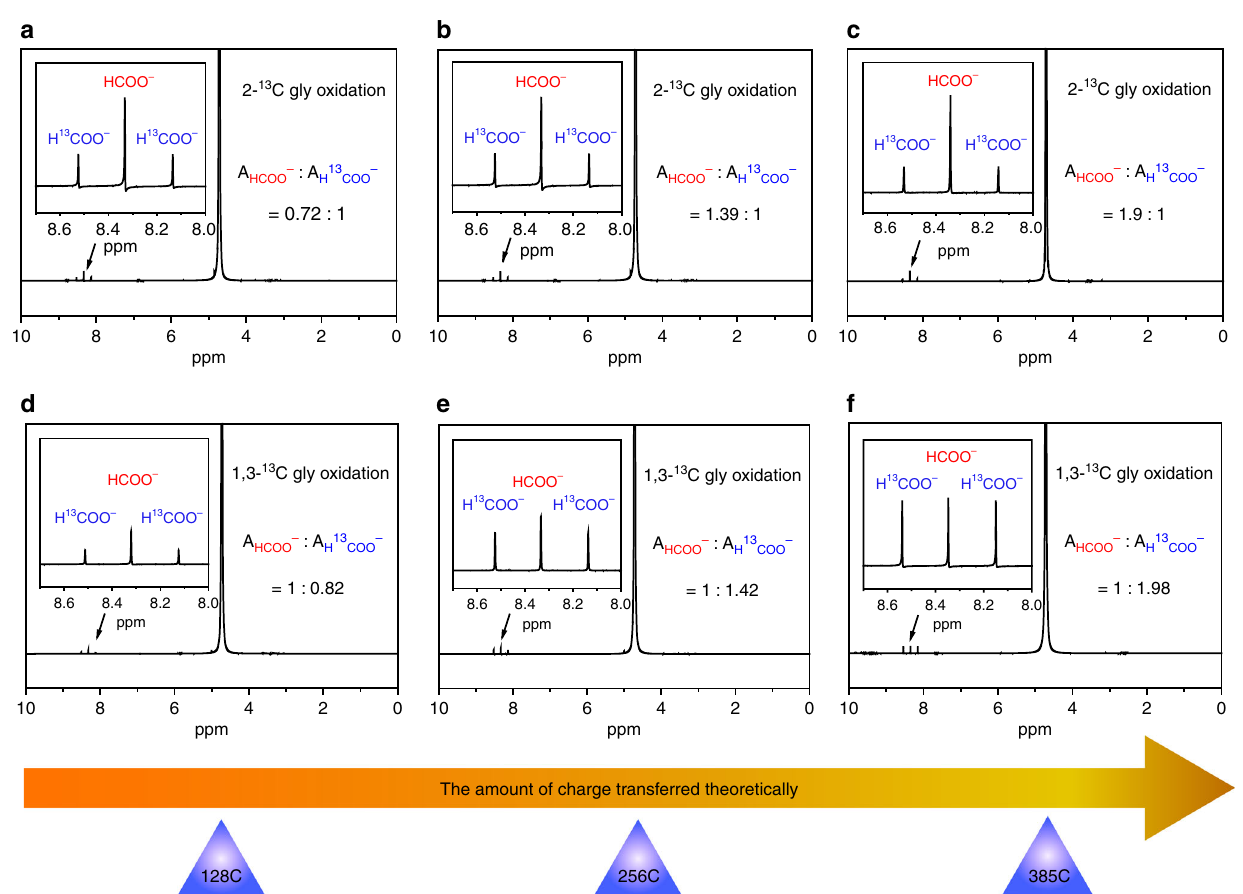
Fig. 3 1 H NMR spectra for the electro-oxidation of 2- 13 C-glycerol and 1, 3- 13 C-glycerol. a – c 0.1 M, 2- 13 C-glycerol conversions theoretically into ~0.1 M ( a ), ~0.2 M ( b ) and ~0.3 M ( c ) formate at 128, 256, and 385 C charges transferred, respectively; d – f 0.1 M 1, 3- 13 C-glycerol conversions theoretically into ~0.1 M ( d ), ~0.2 M ( e ), and ~0.3 M ( f ) formate at 128, 256, and 385 C charges transferred, respectively. A HCOO − and A H 13 COO − are the integral area of HCOO − and H 13 COO − in 1 H NMR spectra,